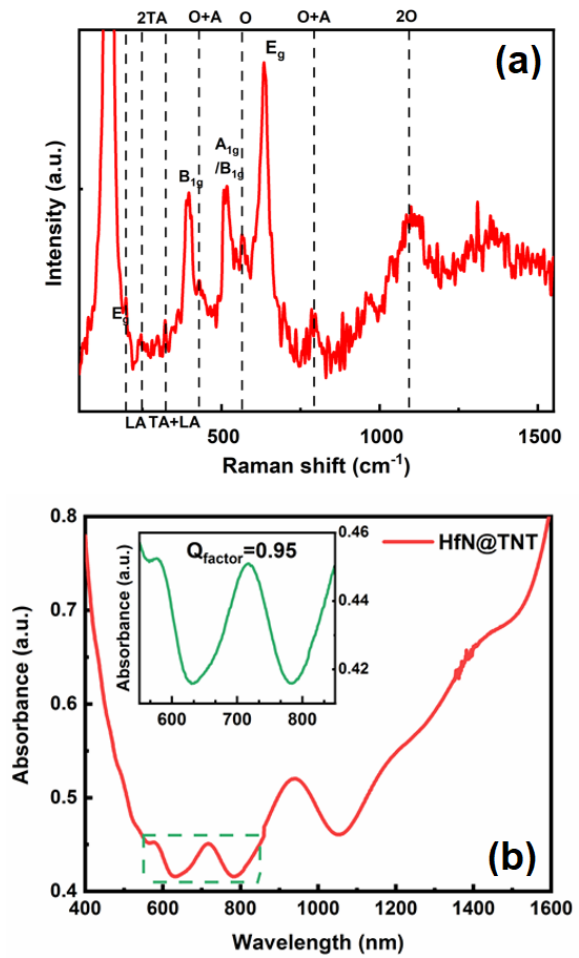
Figure 4. ( a ) Raman spectrum of HfN@TNT, TA stands for transverse acoustic mode, LA stands for longitudinal acoustic mode, O represents optical mode, and ( b ) UV ‐ Vis absorption spectrum of HfN ‐ TNT, and the inset is a zoom ‐ in view of the localized surface plasmon resonance peak and its calculated quality factor.